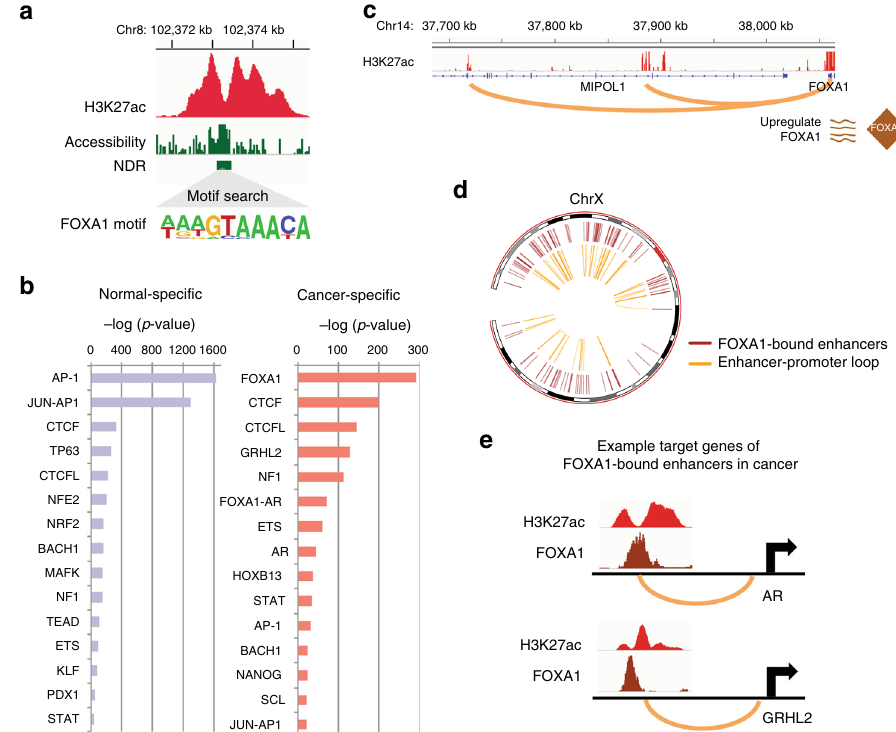
Fig. 5 TFs enriched at cell-type-speci fi c enhancers that loop to promoters. a Shown is an example of a cancer-speci fi c enhancer at chromosome 8q22.3 that has a FOXA1 motif within the NDR. b Shown are the top most frequent TF-binding motifs found in NDRs within enhancers that loop to promoters. Left: Normal-speci fi c enhancer NDRs. Right: Cancer-speci fi c enhancer NDRs. c A genome browser snapshot of the H3K27ac ChIP-seq track and enhancer – promoter loops identi fi ed by in situ Hi-C for the FOXA1 promoter in prostate cancer cells (C42B). d An example of Circos plots showing FOXA1binding sites at C42B enhancers in chromosome X (outer circle) and the enhancer – promoter loops of FOXA1-bound enhancers in C42B (inner circle). e Example target genes (top: AR; bottom: GRHL2) of FOXA1-bound enhancers in prostate cancer cells. Shown are the ChIP-seq tracks for